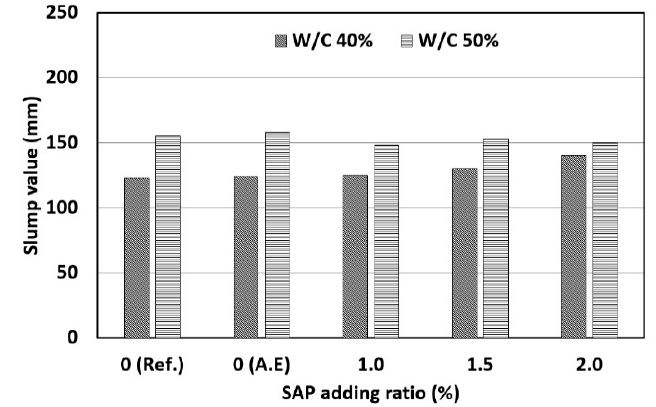
Figure 6. Results of slump value.